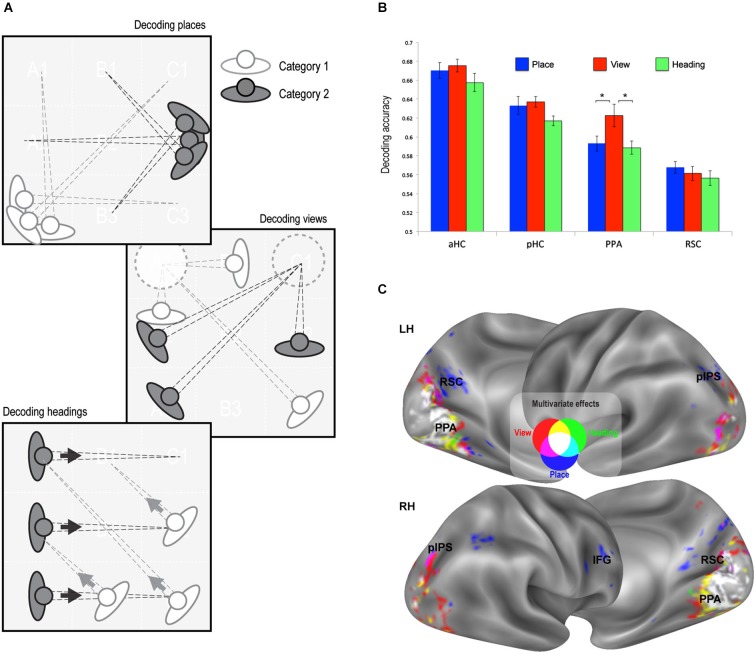
Multivariate classification results. (A) Schematic illustration of the rationale of the classification analysis. Each trial was labeled according to its place, view, and heading. A linear classifier was trained to decode between trials corresponding to each pair of places, views, or heading directions. (B) Classification accuracy in the predefined ROIs (all above chance, p < 0.001). Classification performance was higher for view than for place and heading only in the PPA. * p < 0.01. (C) Whole-brain classification accuracy. Voxels decoding places (blue), views (red) and heading directions (green) significantly better than chance (minimum accuracy = 0.57, p < 0.01 corrected) are superimposed on the lateral and medial surfaces of both left (LH) and right (RH) hemispheres.